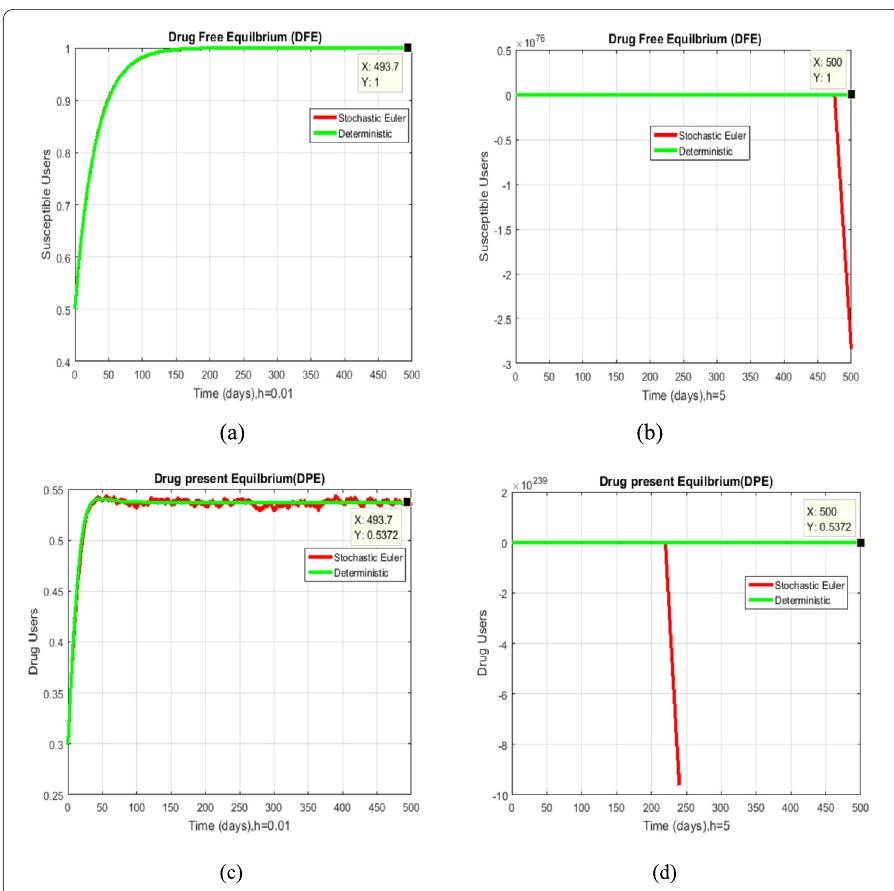
Figure 3 ( a ) In susceptible users’ fraction stochastic Euler method converges to drug-free equilibrium, while deterministic solution is the mean of stochastic Euler method solution for h = 0.01. ( b ) In susceptible users’ fraction stochastic Euler method fails to maintain the positivity and diverges for drug-free equilibrium for h = 5. ( c ) In drug users’ fraction stochastic Euler method converges to drug-present equilibrium, while deterministic solution is the mean of stochastic Euler method solution for h = 0.01. ( d ) In drug users’ fraction stochastic Euler method shows negativity and unstable behavior for drug-present equilibrium for h = 5